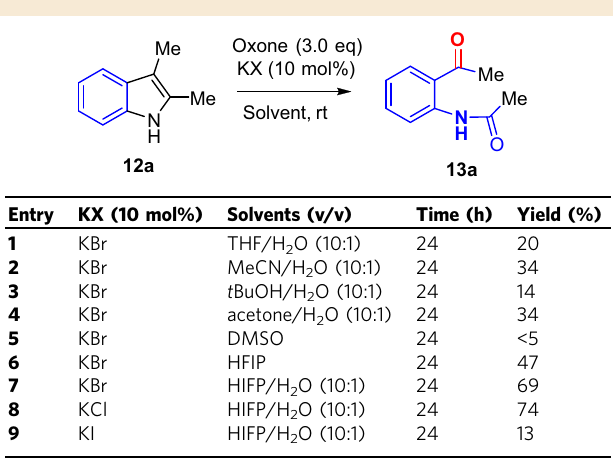
Table 4 Selected conditions for Witkop oxidation with